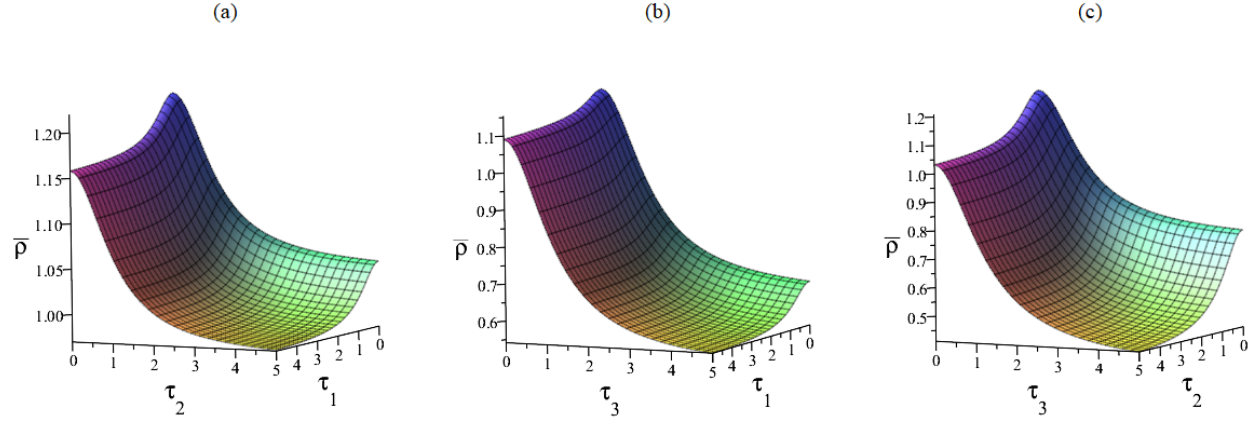
Figure 2. Maximum amplitude ¯ ρ for different correlation times, where ( a ) τ 3 = 0.1, ( b ) τ 2 = 0.8, ( c ) τ 1 = 0.5.